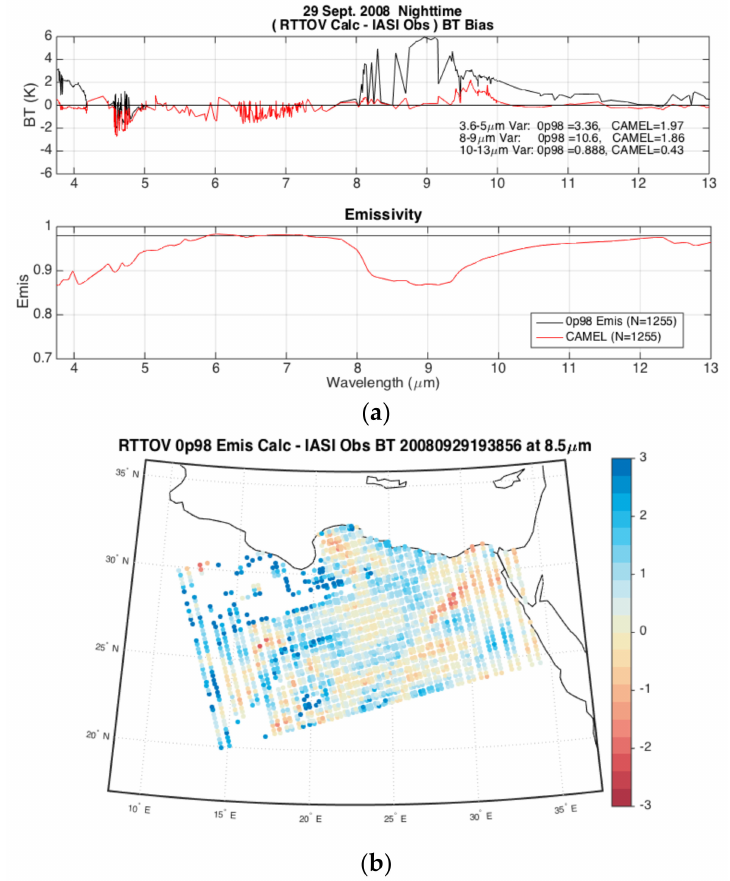
Figure 7. ( a ) Calculated constant 0.98 (black) and CAMEL (red) emissivity brightness temperature (BT) minus observed IASI BT bias (top panel) and mean emissivities (bottom panel) for a 29 September 2008 nighttime granule over Egypt. Number of samples, N, shown in legend. Debiased variances listed for three spectral regions; ( b ) Map of 8.5 µ m calculated CAMEL minus observed IASI BTs differences in